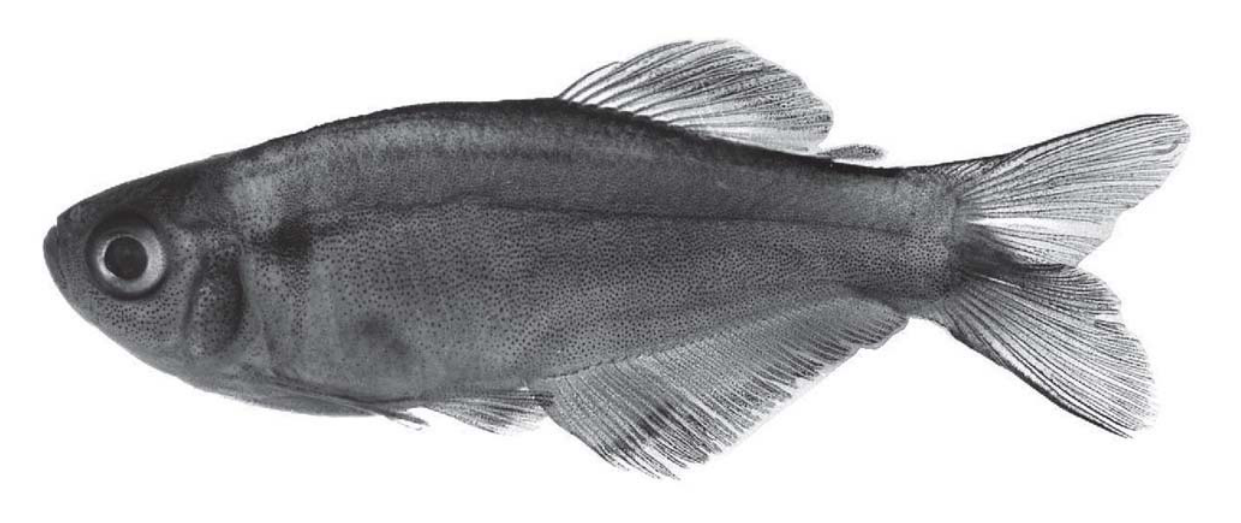
Fig. 29. Mimagoniates inequalis , male, UFRGS 3946, 27.5 mm SL, Brazil, Rio Grande do Sul, lagoa Emboaba, Tramandaí.